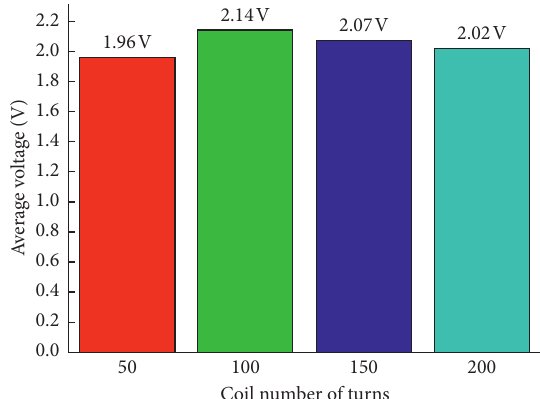
Figure 36: Relation of the average voltage and turns of